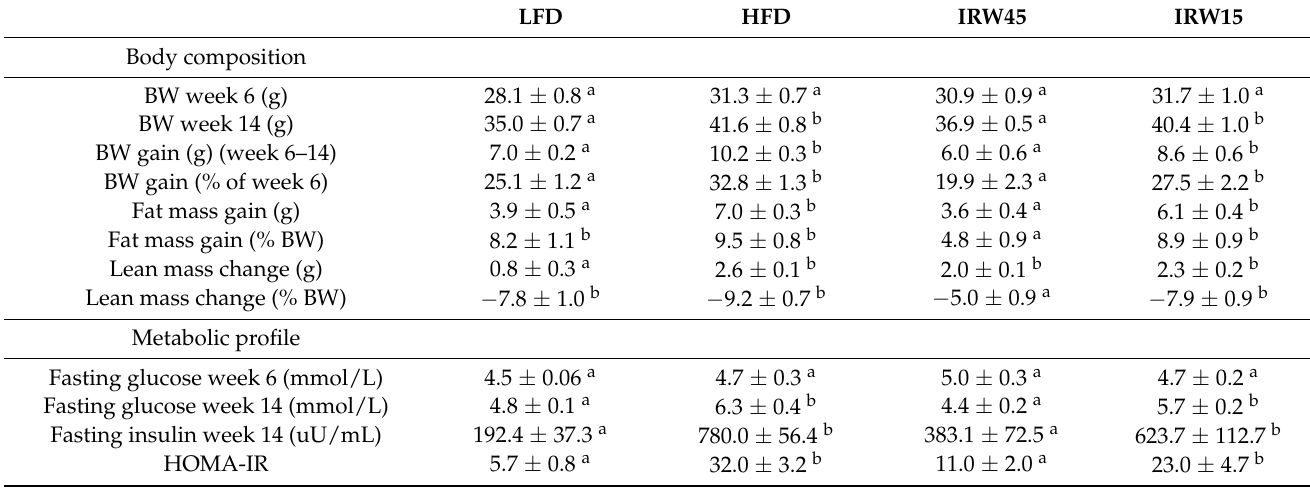
Table 2. Body composition and metabolic profile of mice supplemented with IRW. Analysis by one-way ANOVA followed by Bonferroni’s post hoc test (lean mass change, fasting glucose initial and HOMA-IR) or Kruskal–Wallis’s test followed by Dunn’s post-hoc test. Data expressed as mean ± SEM of n = 7–8 mice. Values in the same row represented by different letters are statistically different ( p ≤ 0.05) compared to HFD